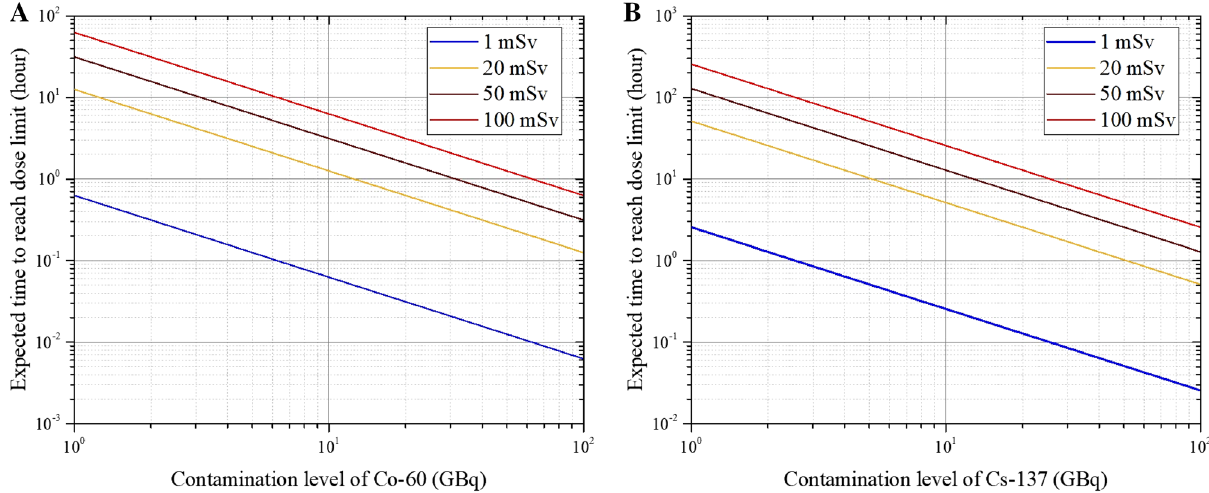
Figure 5. Exposure doses of an emergency medical responder caring for a patient contaminated by a highly radioactive radiation source at a distance of 10 cm for each contamination amount. When the radionuclide is ( A ) 60 Co or ( B ) 137 Cs, a point-source-like contamination (radius 1.25 cm) is assumed on the back of the hand (see Scenario 2 in Table